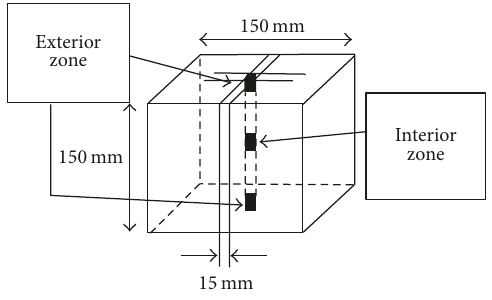
Figure 5: Cutting layout of 15 × 15 × 150 mm. prisms.